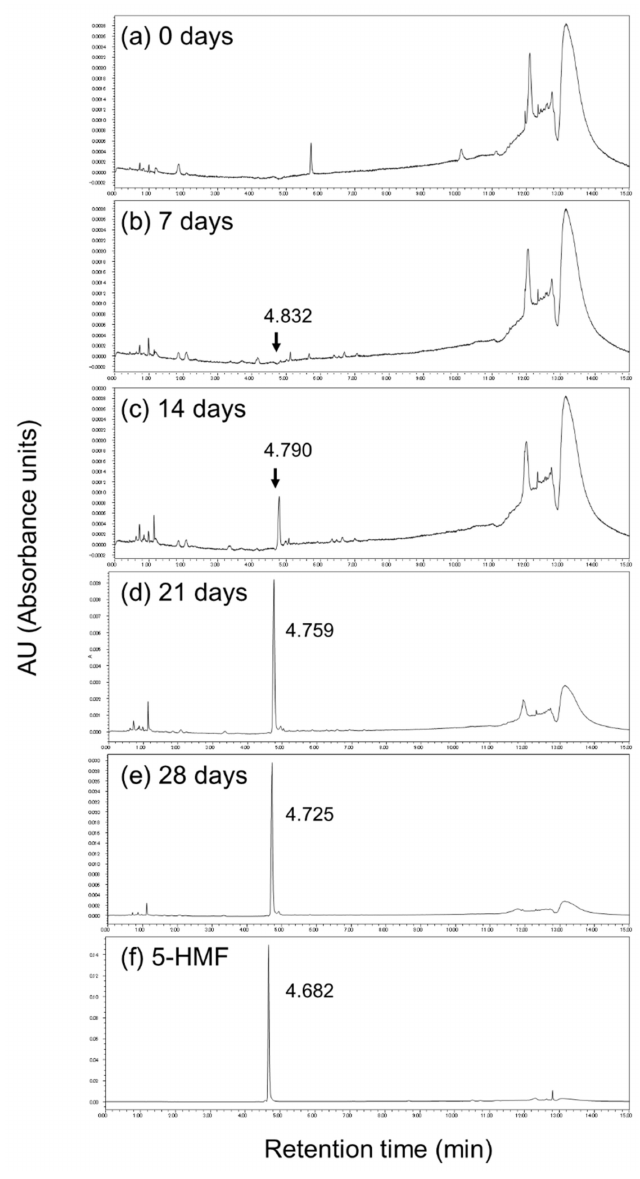
Figure 7. HPLC chromatogram of black garlic extract and 5-hydroxymethyl furfural (5-HMF, C 6 H 6 O 3 ) standard sample detected at 280 nm. ( a ) 0 days, ( b ) 7 days, ( c ) 14 days, ( d ) 21 days, ( e ) 28 days, and ( f ) 5-HMF standard